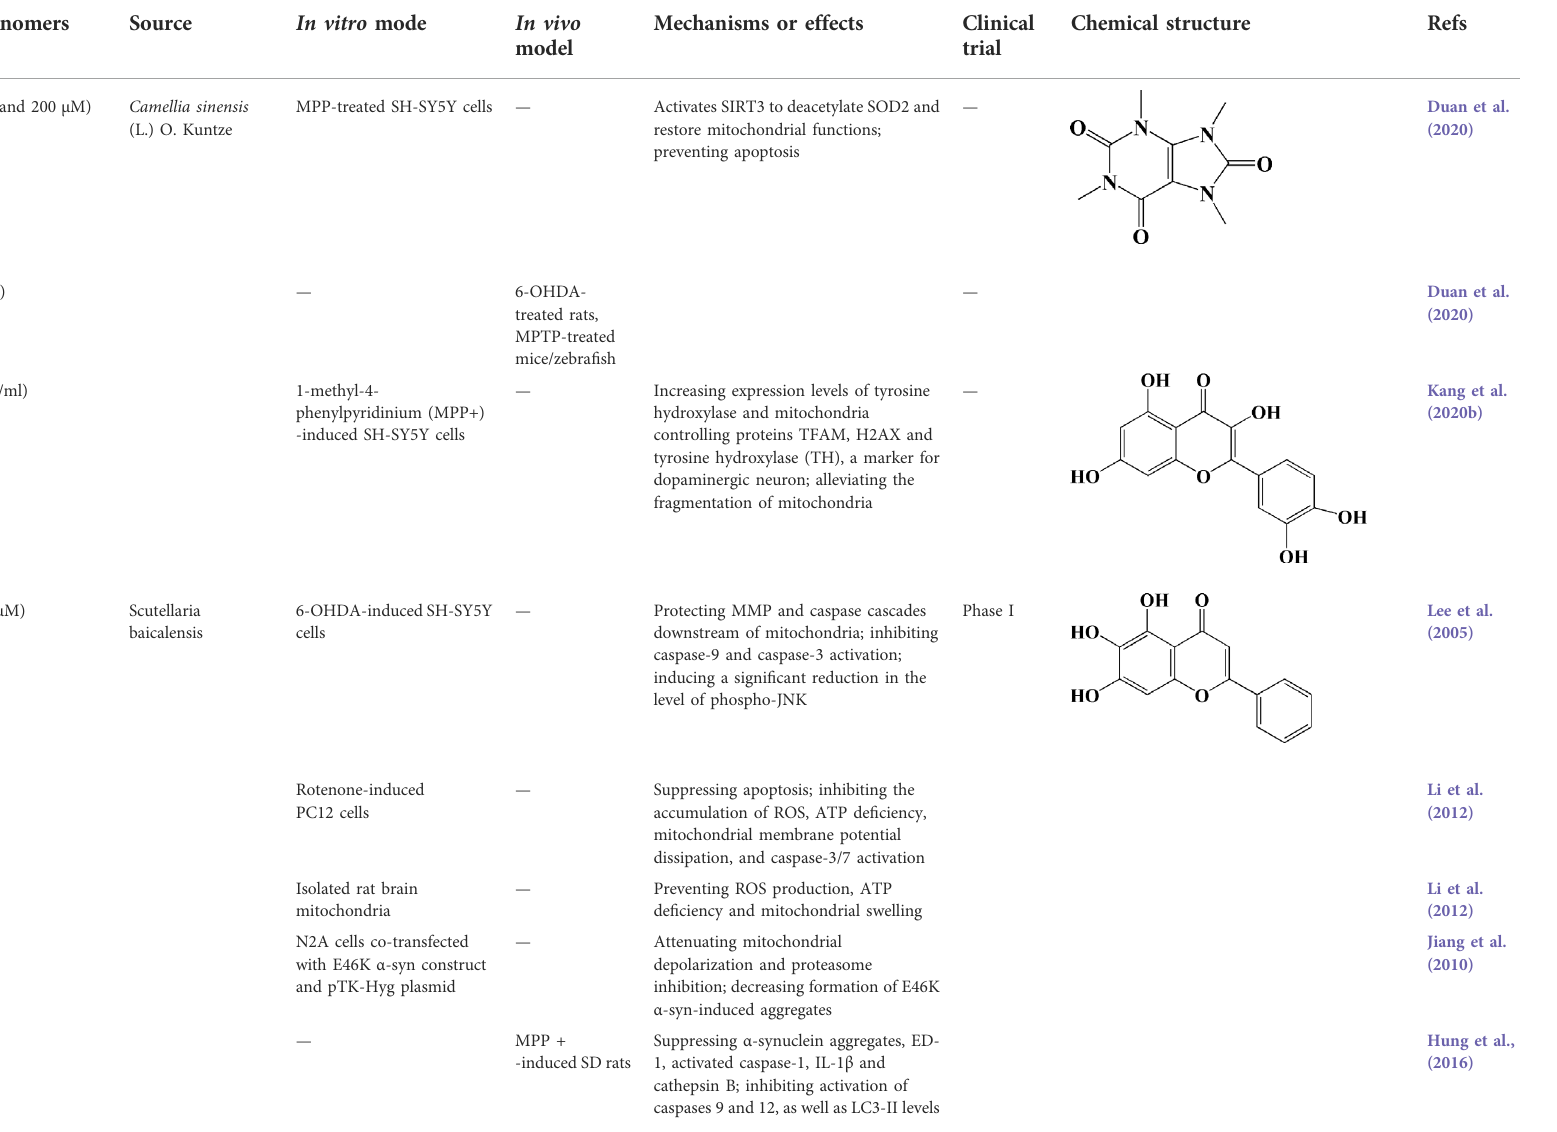
TABLE 1 Mitochondrial dysfunction-associated natural products for